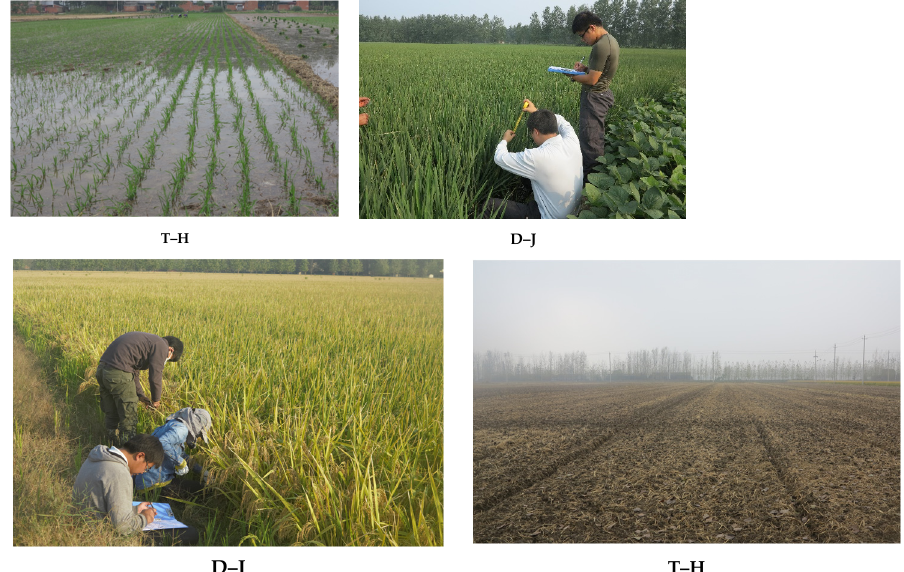
Figure 2. The field synchronization experiment photos.